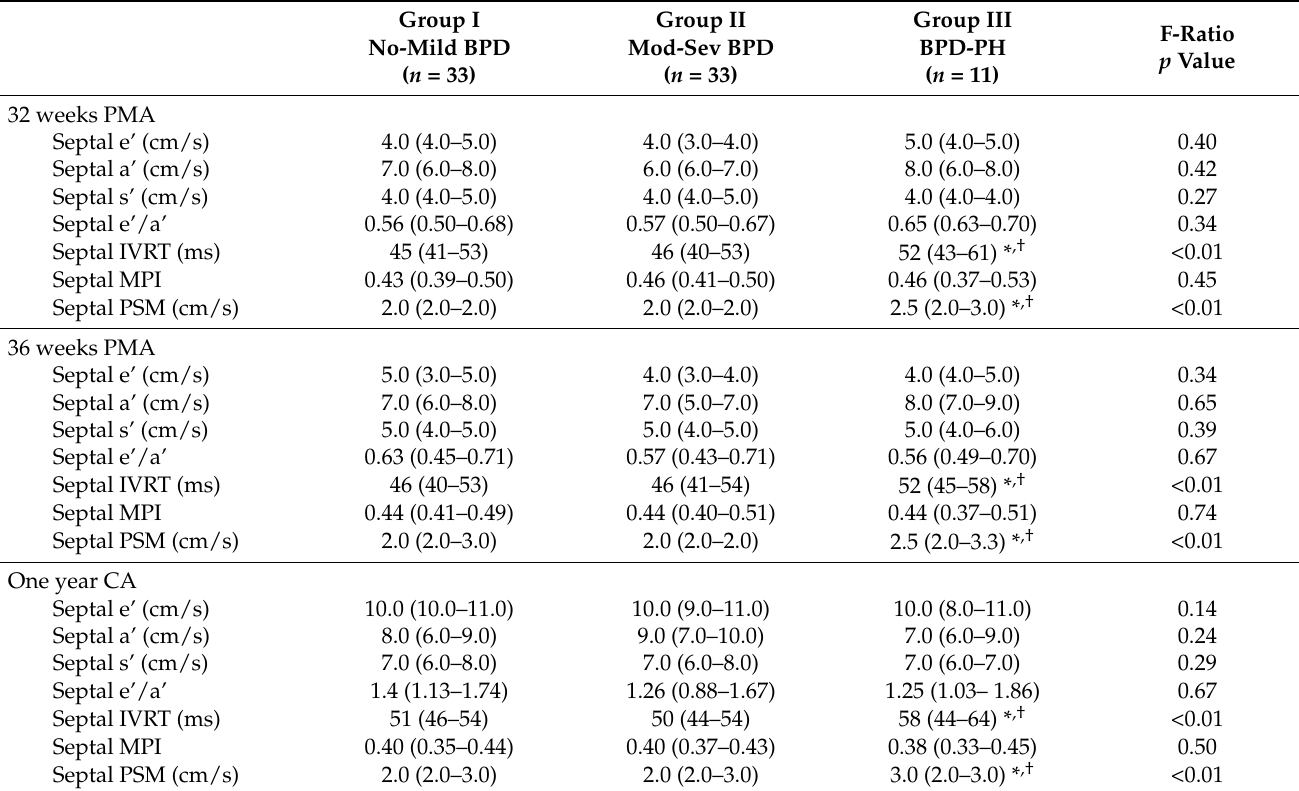
Table 4. LV tissue Doppler indices at the septal side of the mitral valve